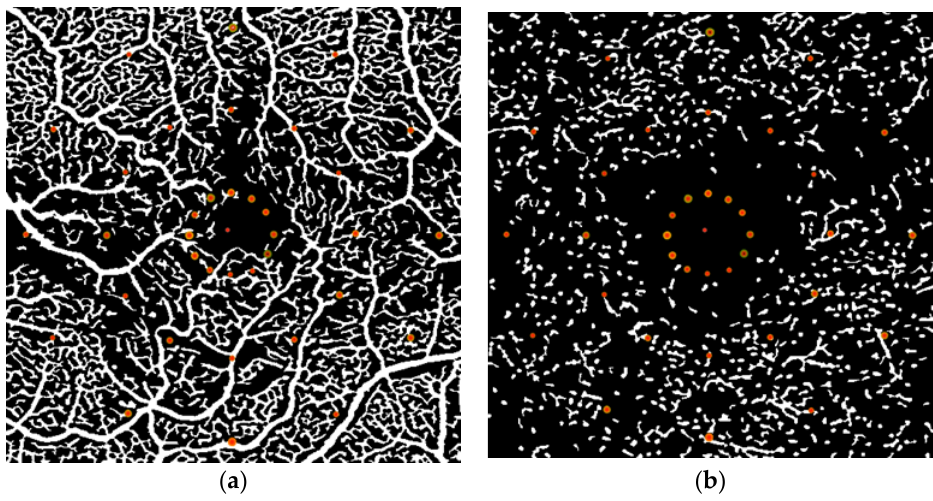
Figure 1. Eye with iERM analyzed by SS-OCT Plex Elite 9000, black and white image showing selectively the SCP ( a ), and DCP ( b ) with overlapped grid of MAIA (red points).